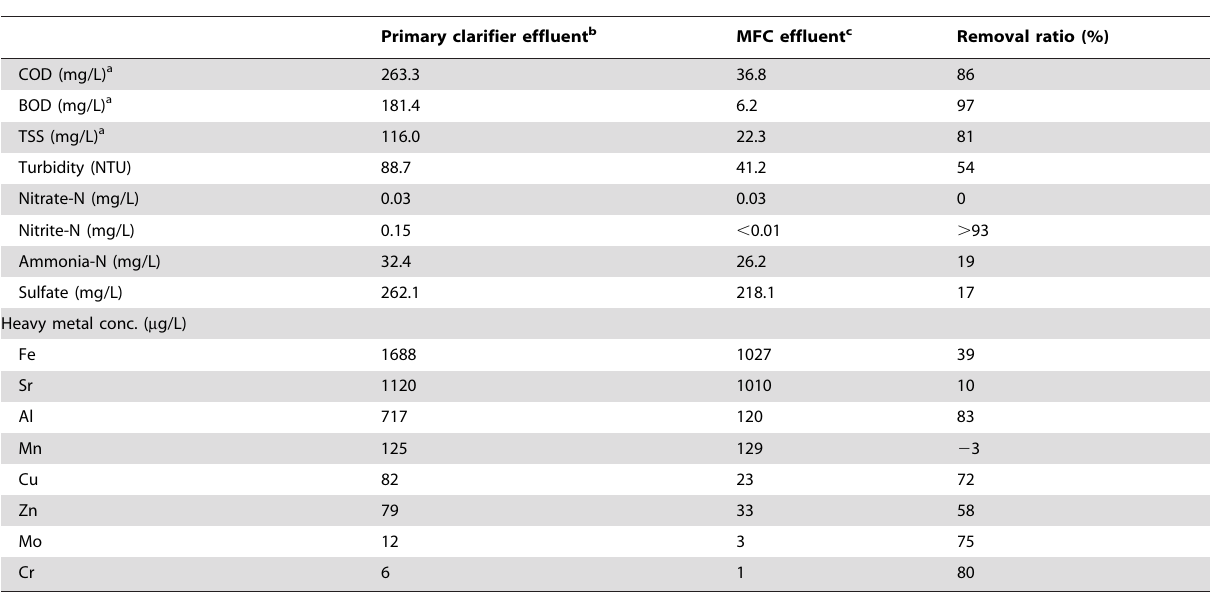
Table 1. Chemical composition of primary clarifier effluent and MFC